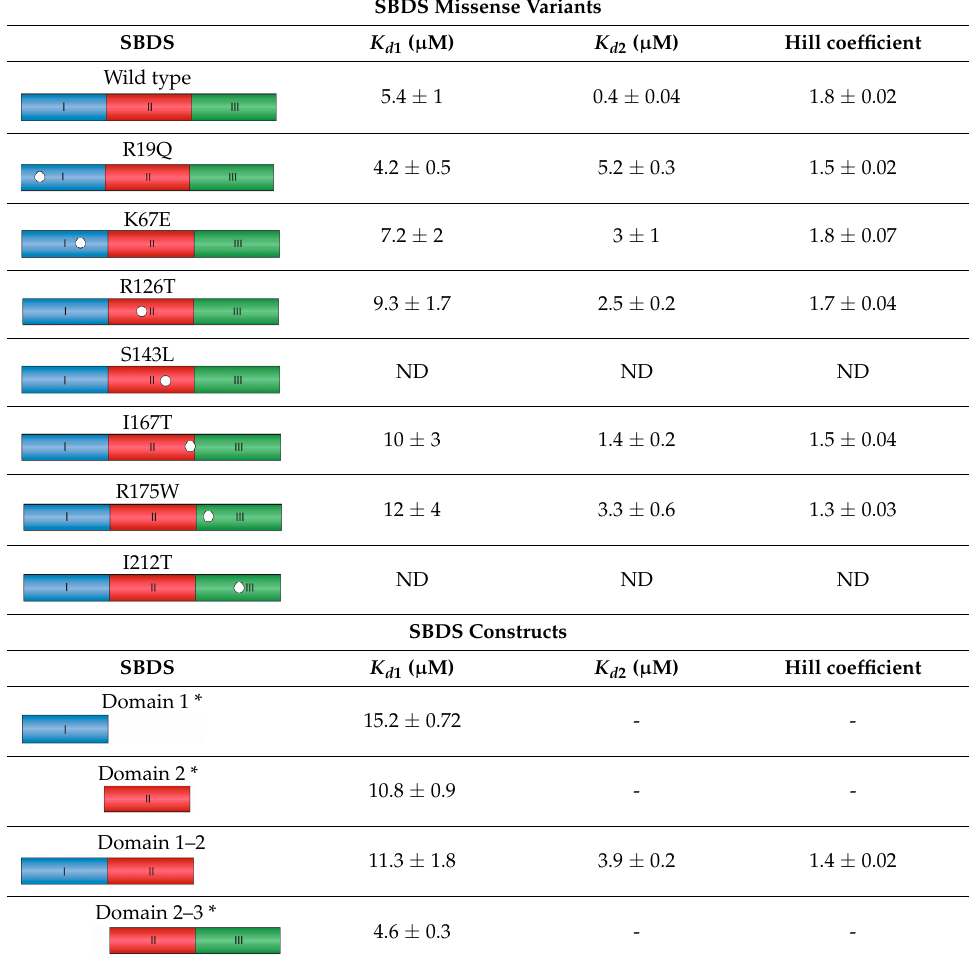
ND—not determined due to a lack of sufficient binding. *Data were fitted to a single binding site model, so there is no second binding event or cooperativity. White dots depicted in the schematic representation of SBDS indicate the relative position of the corresponding missense variant.